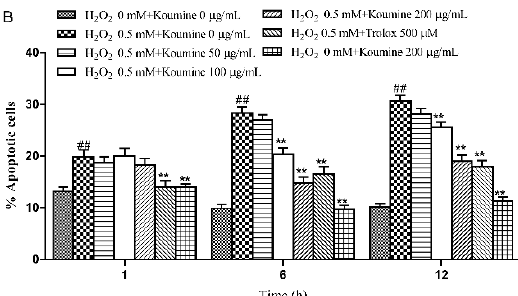
Figure 7. Effect of koumine on H 2 O 2 -induced apoptosis in IPEC-J2 cells (mean ± s.d., n = 5) Legend: # and ## indicate level of significance at p < 0.05 and p < 0.01, respectively, compared with the control group; * and ** indicate level of significance at p < 0.05 and p < 0.01, respectively, compared with the oxidative stress model group. ( A ) Effects of koumine treatment on H 2 O 2 -induced IPEC-J2 cellular apoptosis assayed by flow cytometry analysis of Annexin V-FITC/PI; ( B ) Quantification of the rate of apoptotic cells detected wit flow cytometry.